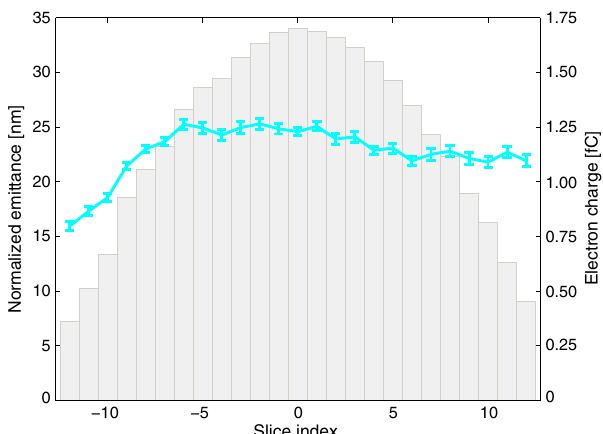
FIG. 4. Normalized slice emittance (cyan, left axes) for a total bunch charge of 30 fC. The error bars are obtained by error propagation of the statistical beam-size errors. The longitudinal bunch charge profile is shown as gray bars (right axes).